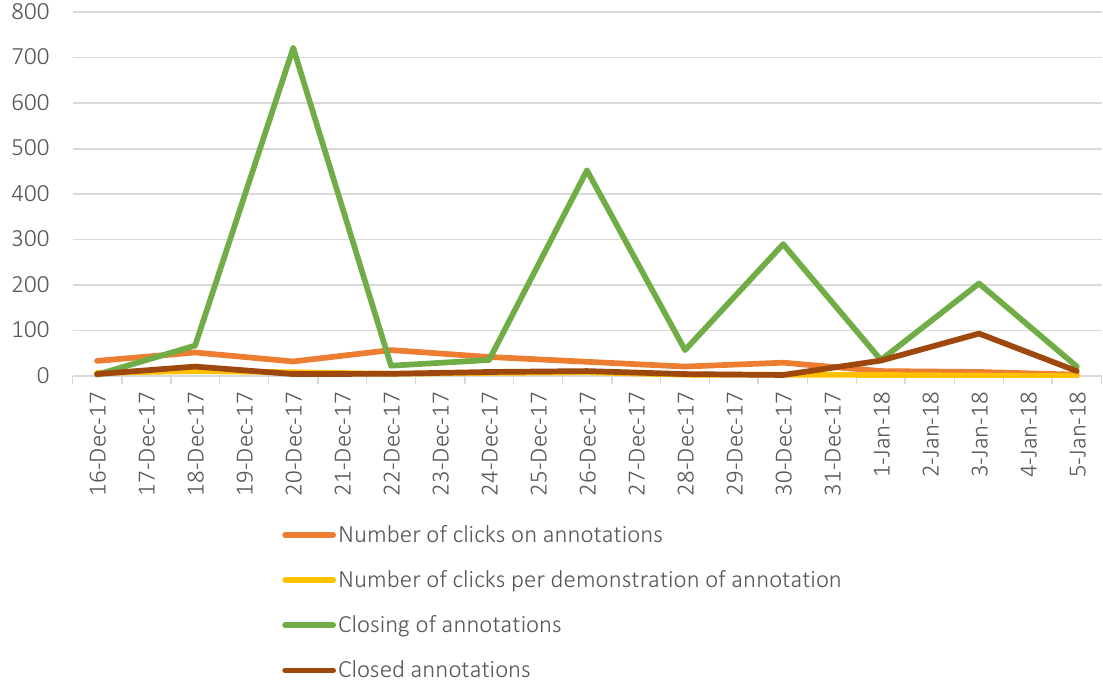
Figure 4. Dynamics of annotations in video clips demonstrations during